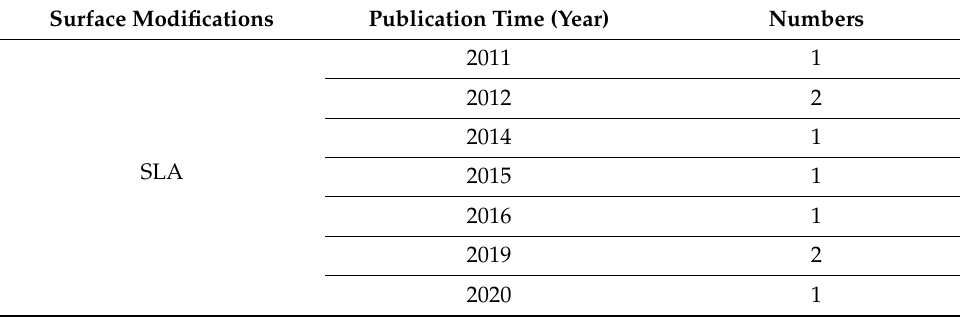
Table 2. The numbers of relevant literature published